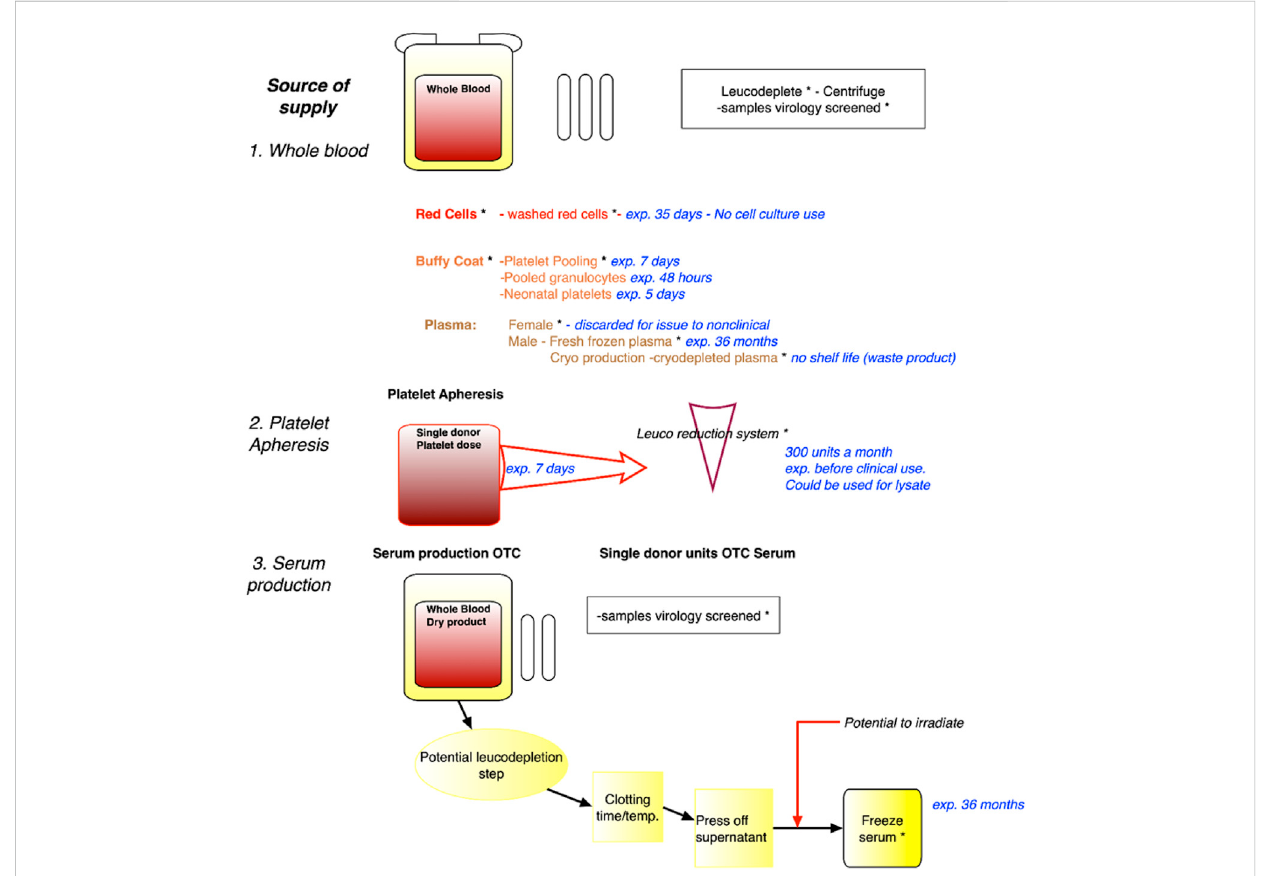
FIGURE 2 Identi fi cationofsourcesofexpired bloodno longer ofuseto themedical/clinicalsciences. Legend.Sourcesofblood, includingwholeblood, blood fractions, platelet apheresis and serum production, with expiry dates such that there will not be any competition with medical use. Safety virology and irradiation steps are indicated. Whilst red blood cells or plasma will not be used for cell culture, platelet lysates and serum can be used. exp. = expired; OTC = Off The